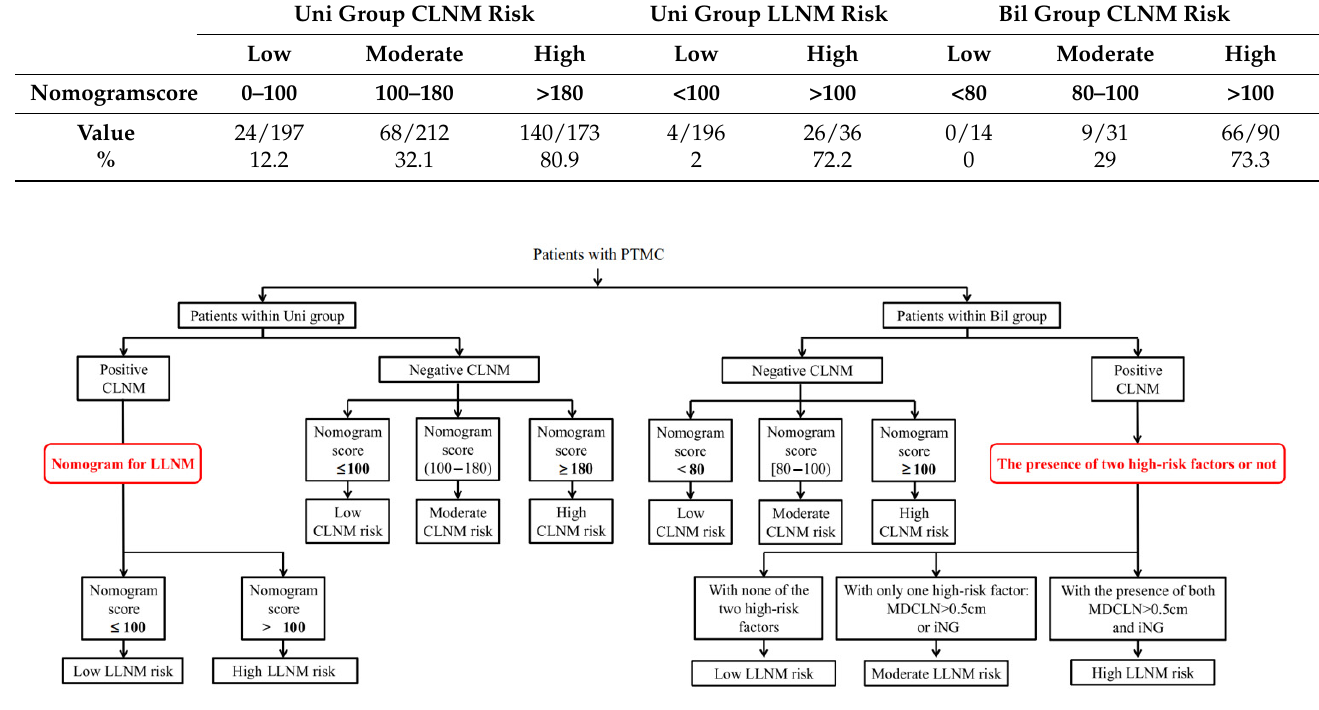
Table 6. Risk stratification of Uni and Bil group of PTC patients based on the model database. Uni Group CLNM Risk